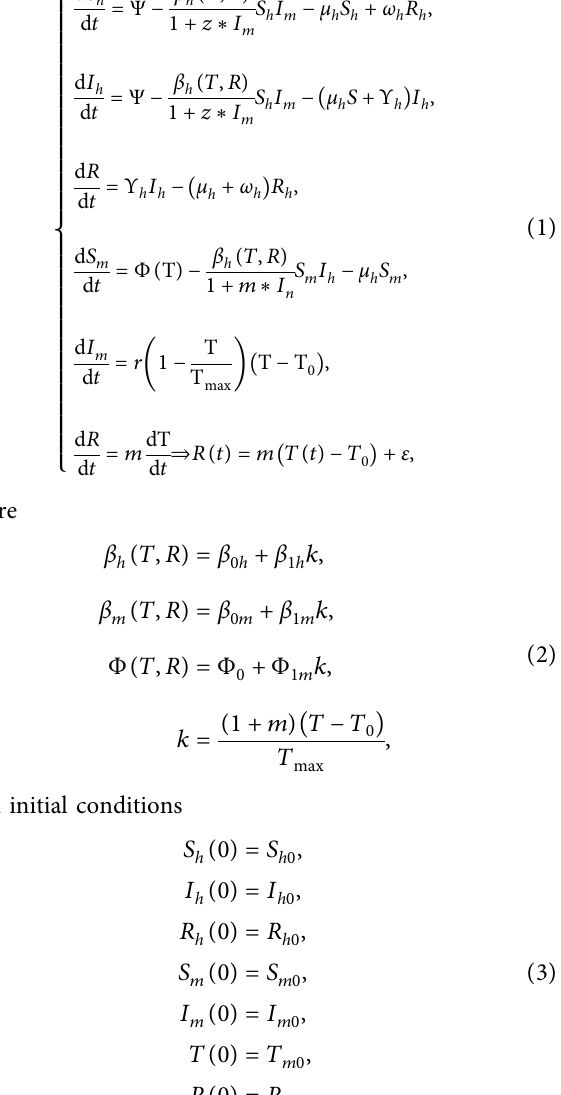
Figure 1: Transmission of malaria disease diagram.